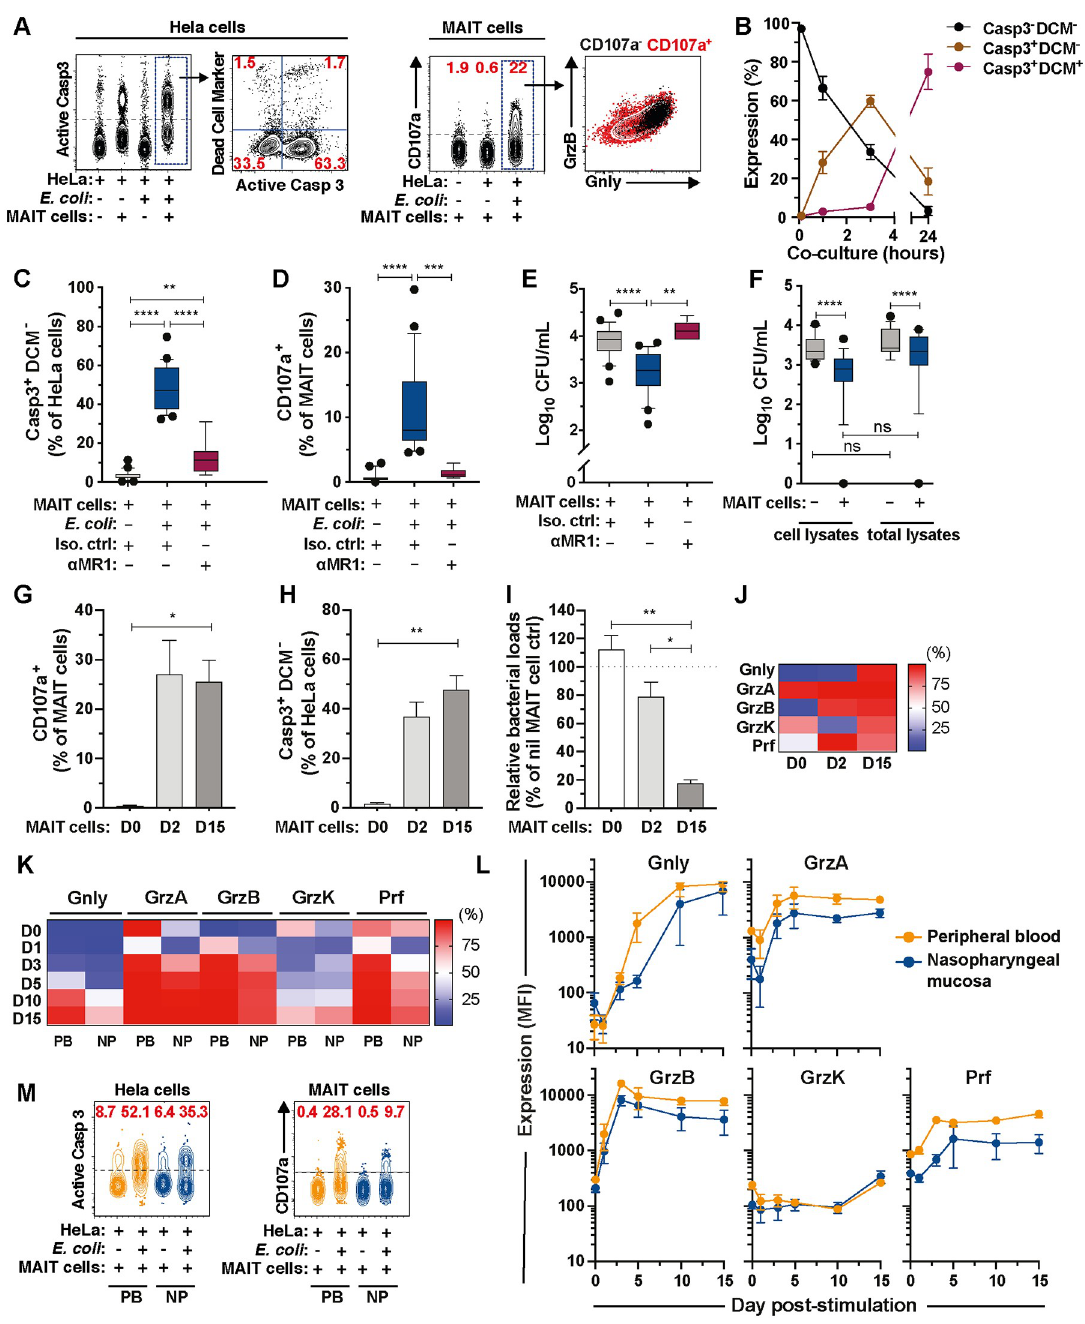
Fig 1. MAIT cells kill bacteria-infected cells and suppress bacterial loads. (A) Assessment of apoptosis of E . coli EC120S-infected HeLa cells by Casp3 activity and MAIT cell degranulation by CD107a, Gnly, and GrzB expression. (B) Apoptosis of infected HeLa cells at indicated time point ( n = 9–11). (C) Measurement of early apoptosis (Casp3 + DCM − ) on uninfected or EC120S-infected HeLa cells, (D) degranulation by MAIT cells, and (E) bacterial counts following lysis of infected HeLa cells after 3 h of co-culture with and without MAIT cells in the presence of anti-MR1 or isotype control ( n = 7–8 for EC120S-infected HeLa cells+anti-MR1, n = 24–25 for others). (F) Bacterial counts in infected HeLa cell lysates or in total lysates (cell lysates plus supernatants) after 3 h of co-culture with or without MAIT cells ( n = 14). (G) MAIT cell degranulation, (H) apoptosis of EC120S-infected HeLa cells, and (I) relative bacterial loads following co-culture of EC120S-infected HeLa cells with MAIT cells derived from D0, 2, and 15 of culture ( n = 4). (J) Percentage of cytolytic proteins expressed by MAIT cells from D0, 2, and 15 of culture assessed by flow cytometry ( n = 3–10). (K, L) Flow cytometry analysis on frequency (K) and levels (MFI) (L) of cytolytic protein expression by PB ( n = 4) and NP ( n = 3) MAIT cells at various time points. (M) Representative FACS plot of apoptosis of EC120S-infected HeLa cells and MAIT cell degranulation following co-culture with PB or NP